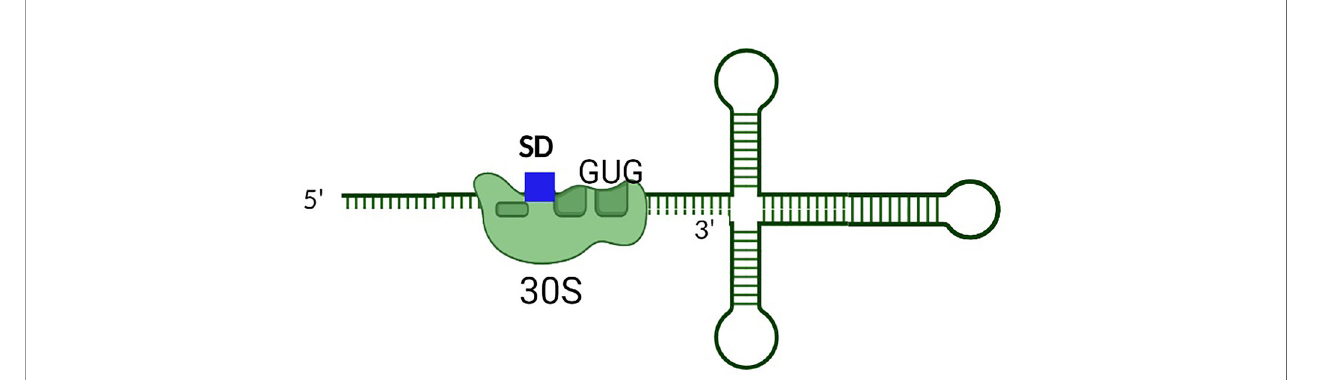
FIGURE 6 | The presence of a non-AUG translational start codon is a secondary mechanism to limit the production of some Type I toxins. In this example, the presence of the non-AUG translational start codon results in partial inhibition of translation from the toxin transcript. Such regulation limits the production of Type I toxins when its activity would be deleterious to the